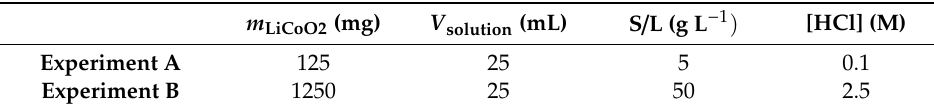
Table 1. Experimental